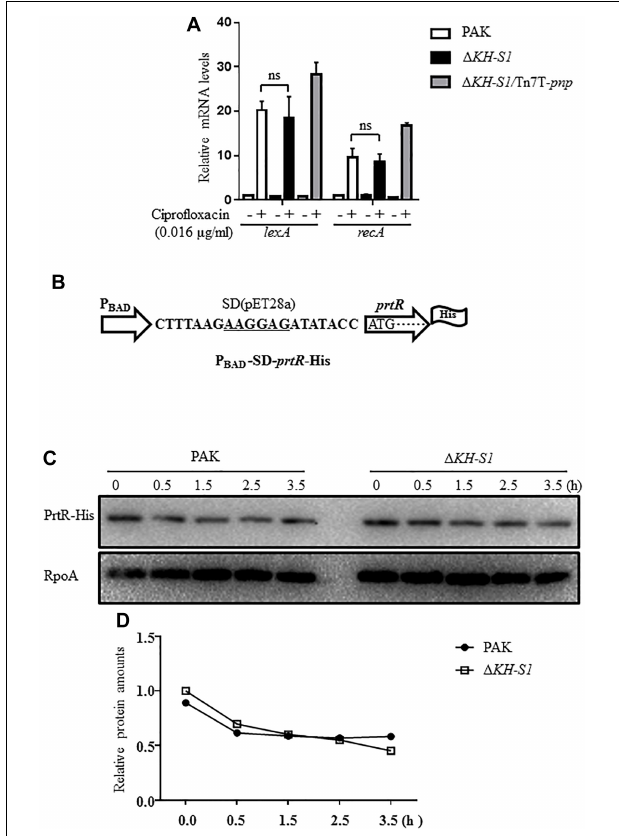
FIGURE 5 | PrtR protein stabilities in PAK and the (cid:49) KH-S1 mutant. (A) PAK, (cid:49) KH-S1 and the complemented strain were grown to an OD600 of 0.8–1.0 at 37 ◦ C with or without 0.016 µ g/ml ciprofloxacin. The mRNA levels of lexA and recA were determined by real-time PCR with rpsL as the internal control. ns, not significant by Student’s t -test. (B) The C-terminal 6 × His-tagged prtR is driven by an inducible P BAD promoter with an exogenous ribosome binding site (designated as P BAD -SD- prtR -His). The ribosome binding sequence was underlined. (C,D) Strains carrying the P BAD -SD- prtR -His were grown to an OD 600 of 0.6–0.8 at 37 ◦ C, followed by induction with 0.2% arabinose for 1.5 h. Then, 500 µ g/ml chloramphenicol and 0.016 µ g/ml ciprofloxacin were added to the medium. At the indicated time points, bacterial cells of each strain were collected and the levels of PrtR-His were determined by Western blotting. RpoA was used as the loading control. The relative intensity of each band was quantified by